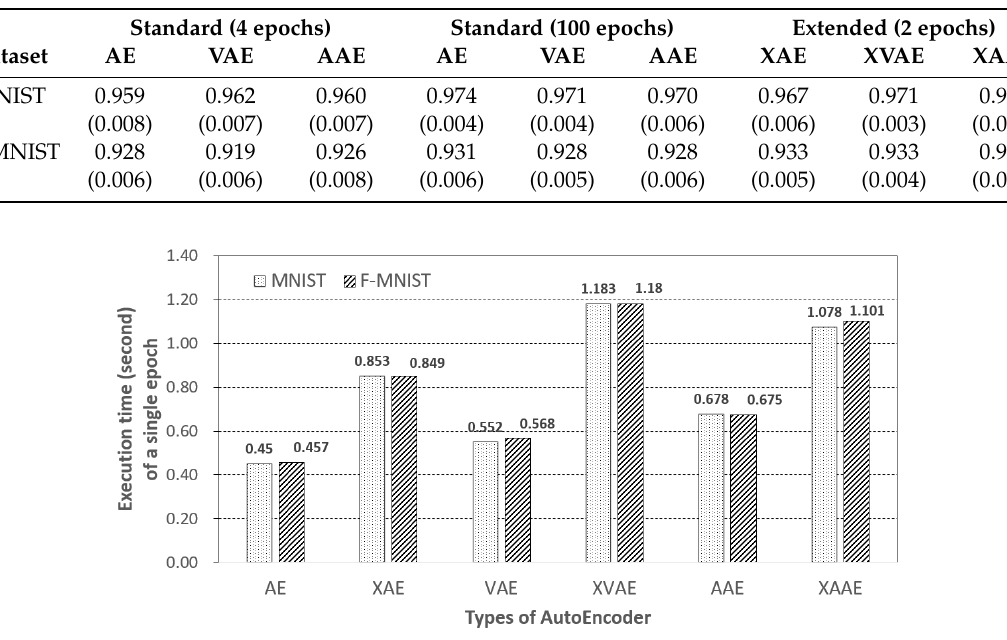
Figure 7. The average execution time of a single training epoch for MNIST (Modified National Institute of Standards and Technology) and F-MNIST (Fashion Modified National Institute of Standards and Technology) datasets .